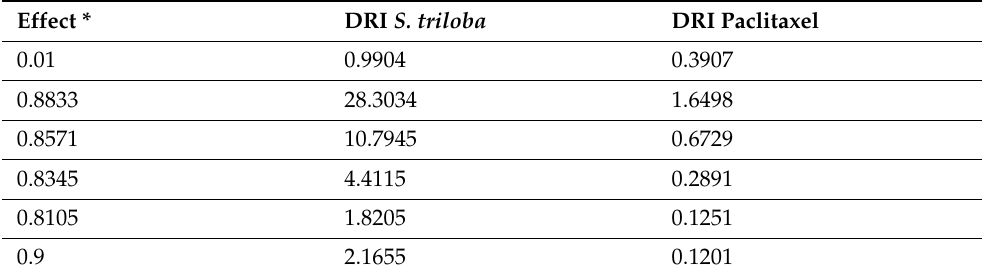
Table 6. Dose reduction index (DRI) values calculated at experimental points for SKOV3